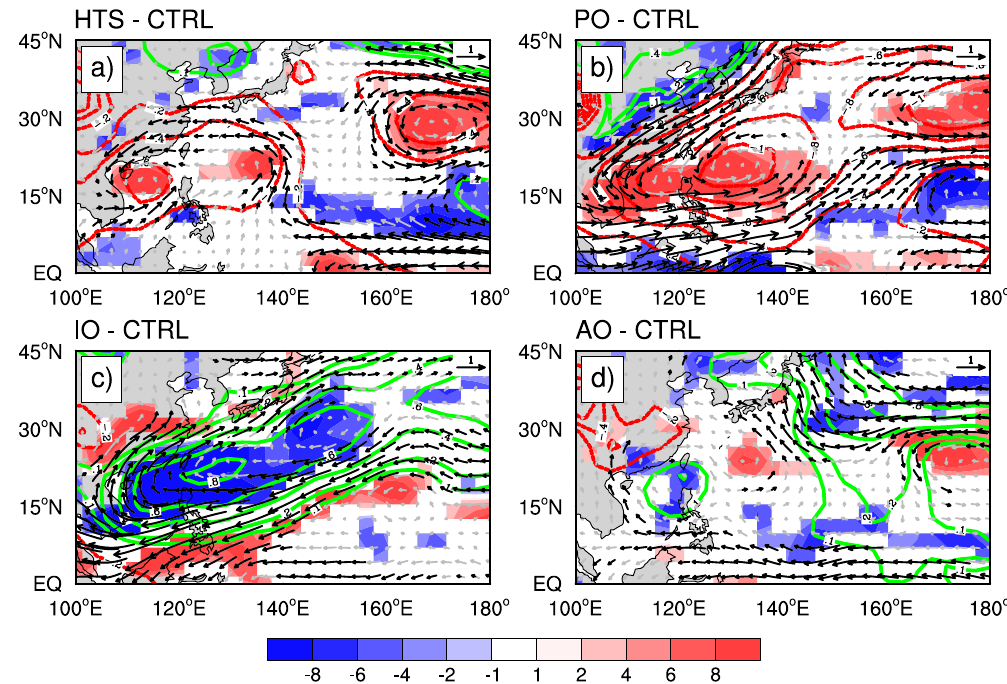
Figure 5. The relative contributions of the GWH-related SSTAs in different ocean basins. Differences in the simulated SLP (green and red contours, unit: hPa), 850 hPa relative vorticity (blue and red shades, unit: 2 × 10 − 7 s − 1 ) and winds (grey and black vectors, unit: 0.8 m s − 1 ) between ( a ) the HTS run, ( b ) the Pacific Ocean (PO) run, ( c ) the Indian Ocean (IO) run, ( d ) the Atlantic Ocean (AO) run, and the control (CTRL) run. All difference fields were averaged in JASON. This figure was generated by the NCAR Command